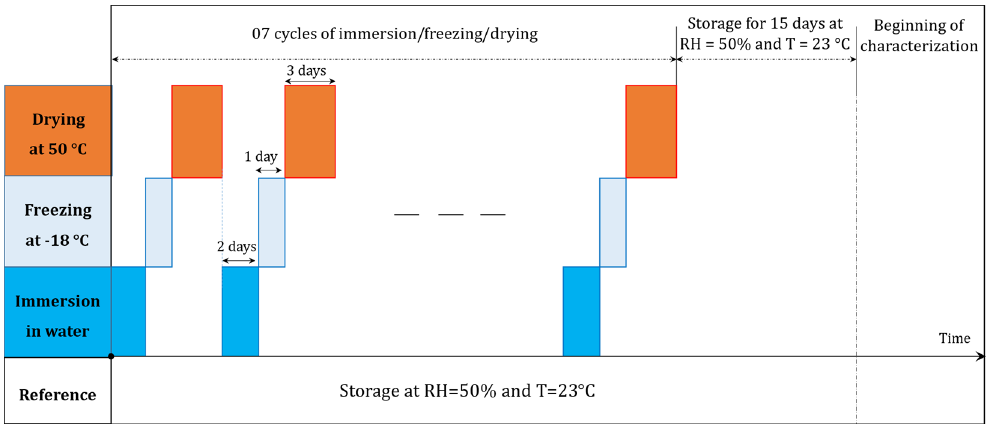
Figure 4. Accelerated aging protocol (immersion/freezing/drying).